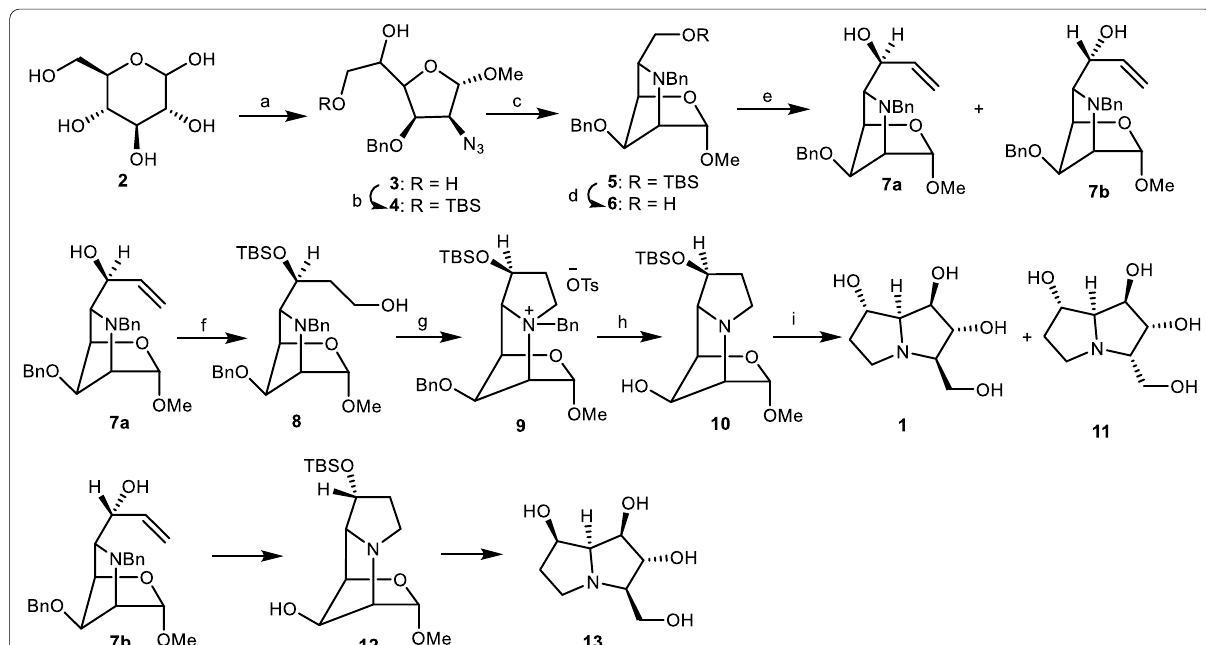
Scheme 1 Fleet method for the synthesis of the alexine 1 , 3-epialexine 11, and 7-epialexine 13 . Reagents and conditions: (a) ref [23]; (b) TBSCl, DMF, 0 °C, 95%; (c) (i)Tf 2 O, pyridine, 30 °C; (ii) H 2 , Pd, EtOAc; (iii) BnBr, DMF, NaOH, 77% overall for 3 steps; (d) TBAF, THF, 88%; (e) (i) oxalyl chloride, − DMSO, Et 3 N; (ii) CH 2 = CHMgBr, THF, 7a : 38%, 7b : 37%; (f) (i) TBSCl, 89%; (ii) BH 3 .DMS, THF, then H 2 O 2 , OH, 67%; (g) (i) p -TsCl, pyridine, CH 2 Cl 2 , 77%; (h) H 2 , Pd/C, aq. acetic acid, 72%; (i) (i) TFA/H 2 O, 36 h; (ii) NaBH 4 , EtOH,